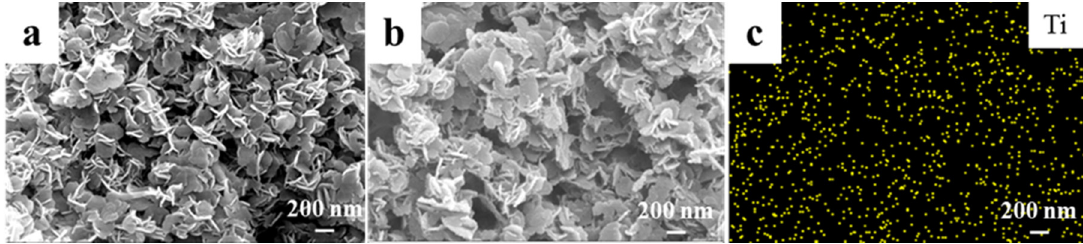
Figure 2. SEM images of ( a ) NiAl-LDHs and ( b ) LDHs@TA-Ti. ( c ) Ti-distribution EDS map-scanning of LDHs@TA-Ti.